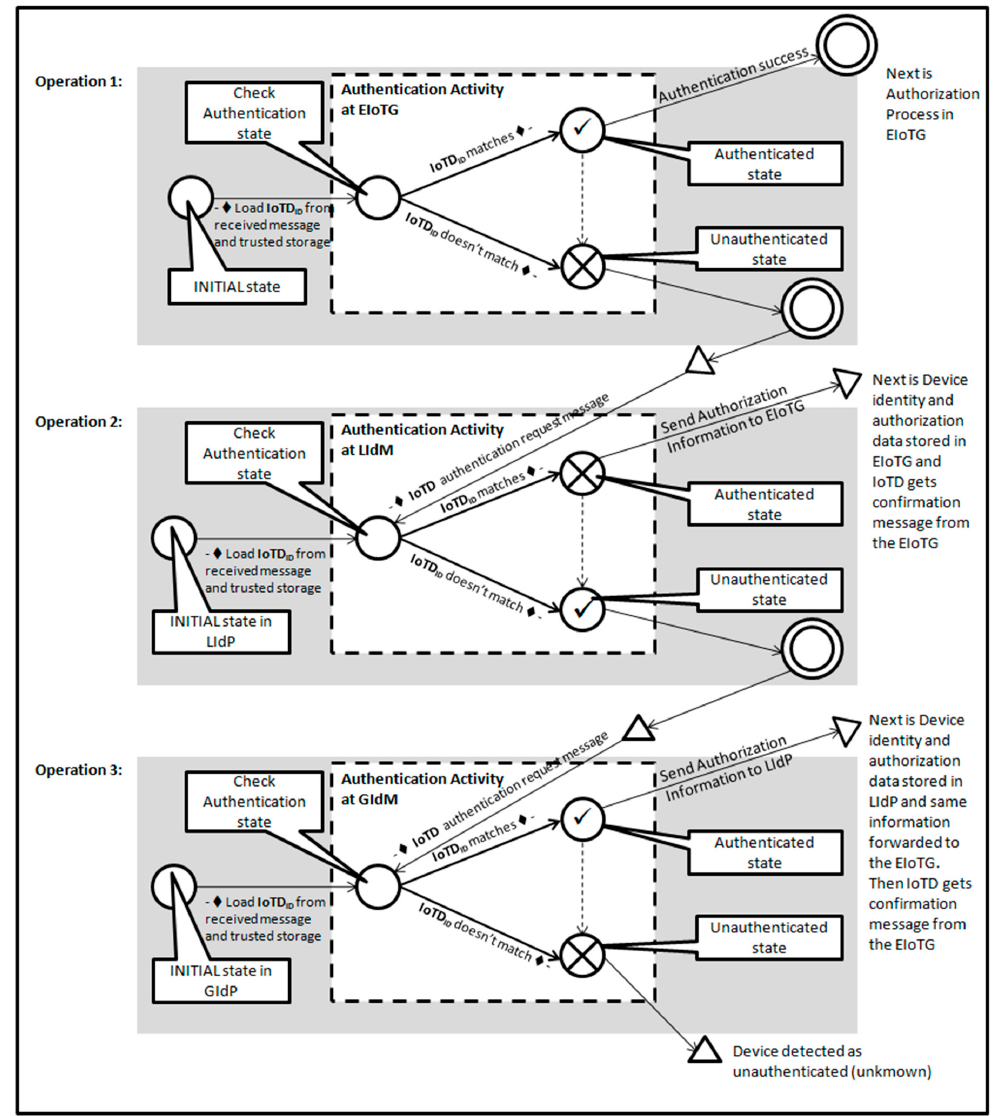
Figure 11. Authentication process for an IoTD at EIoTG, LIdP and GIdP.